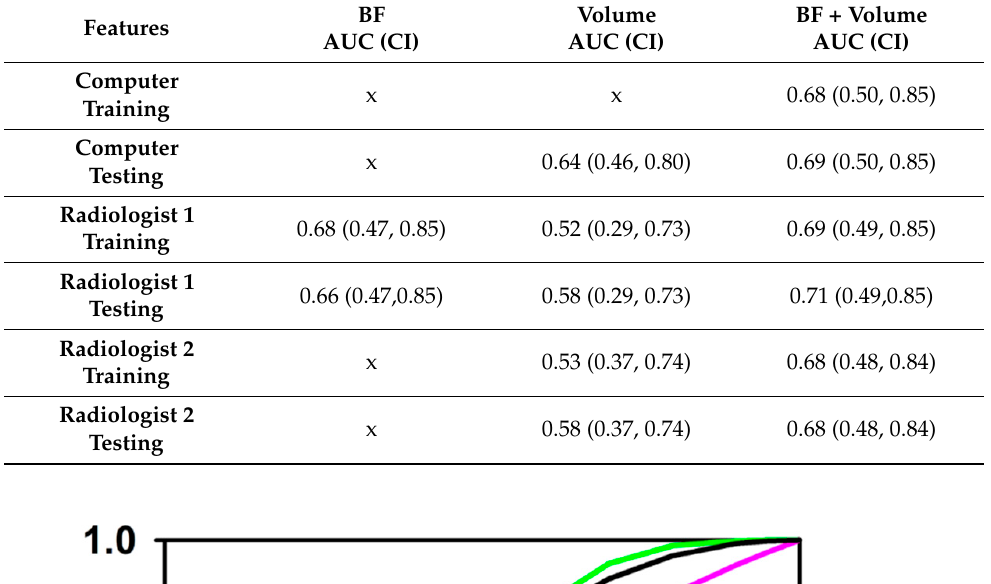
Table 1. Training and testing area under the receiver operating characteristic (ROC) curve (AUC) with 95% confidence intervals (CI) for predicting which patients would not achieve disease free survival at 1 year using change in blood flow (BF) + percent change in volume (volume) for 36 pre- and post-induction therapy tumors. BF was estimated within Radiologist 1 (cid:48) s defined regions by vendor’s software, percent volume change was calculated with computer or Radiologist 1 or Radiologist 2 (cid:48) s manual segmented contours as labeled in column 1. BF Features AUC (CI)